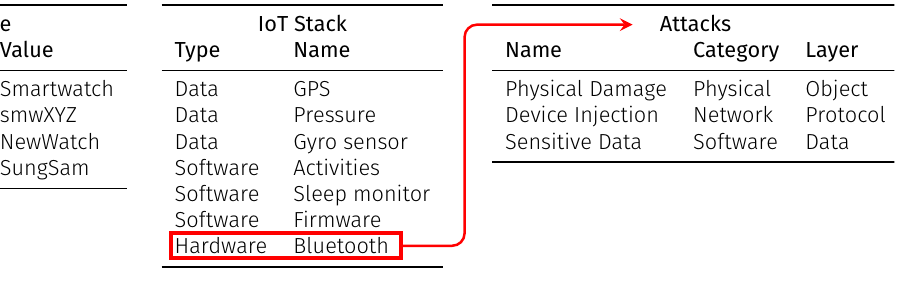
Figure 2. IoT Stack